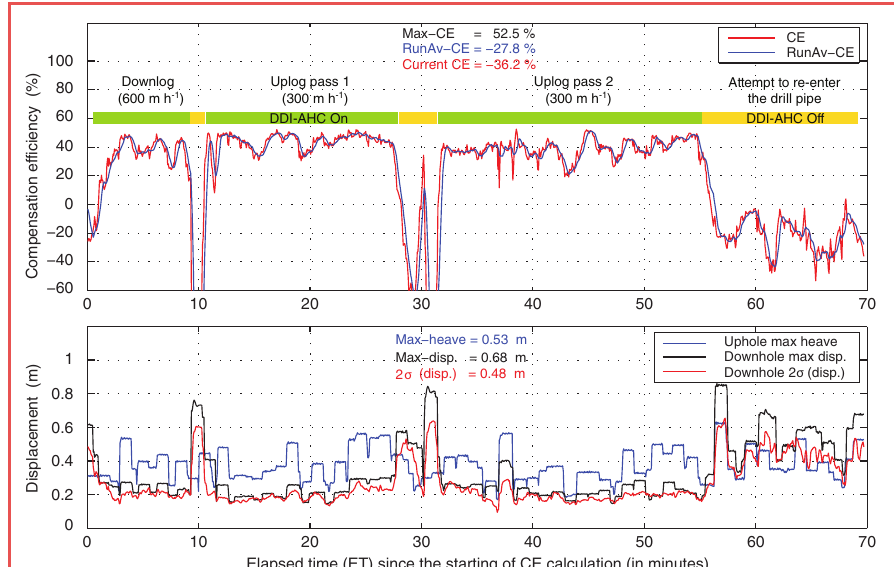
70 Elapsed time (ET) since the starting of CE calculation (in minutes) Figure 5. An example of typical real-time CE evaluation and display of the Schlumberger AHC efficiency. This example is taken from a triple combination tool string deployment during IODP Exp. 340 logging operations in Hole U1395B. The assessment was done in intermediate water depths (1209 mbrf) and low heave conditions (±0.3–0.5 m). Modified from Liu et al., 2012.